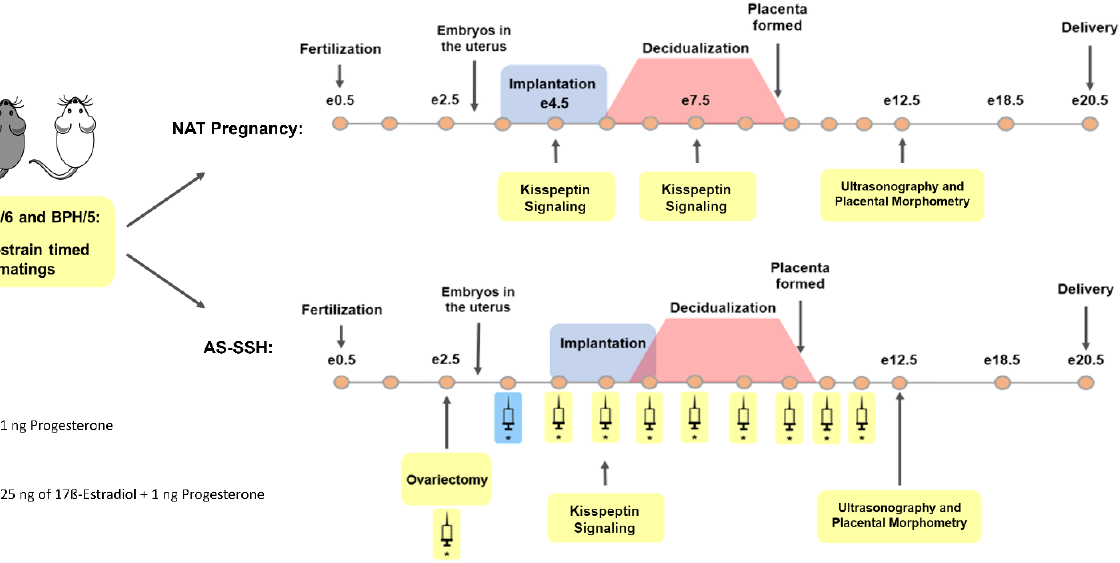
Figure 1. Sample collection of natural (NAT) pregnancies and after artificial synchronization of sex steroid hormone profile (AS-SSH) in the preeclamptic-like BPH/5 mouse and C57BL/6 (C57) normotensive controls. In NAT pregnancies, embryonic implantation sites (eIS) of strain matched pregnancies were collected during the peak of embryonic implantation and decidualization at embryonic days (e) 4.5 and e7.5, respectively. For AS-SSH, strain-matched timed matings were performed and pregnant BPH/5 and C57 females underwent ovariectomy in the afternoon of e2.5. A single dose of 17 β -estradiol (E2, 25 ng/mouse, subcutaneously) was administered one day after surgery to stimulate embryonic implantation, and daily subcutaneous injections of progesterone (P4, 1ng/mouse) were given until the day of sample collection. Two days post E2 injection, eIS were harvested from AS-SSH BPH/5 and AS-SSH C57 females for investigation of kisspeptin expression and signaling. A cohort of NAT and AS-SSH females was anesthetized at e12.5 and 9 days post-E2 administration, respectively, for ultrasonographic assessment of fetal heart rate and umbilical blood flow. Collection of fetoplacental units was then performed for placental morphometry.